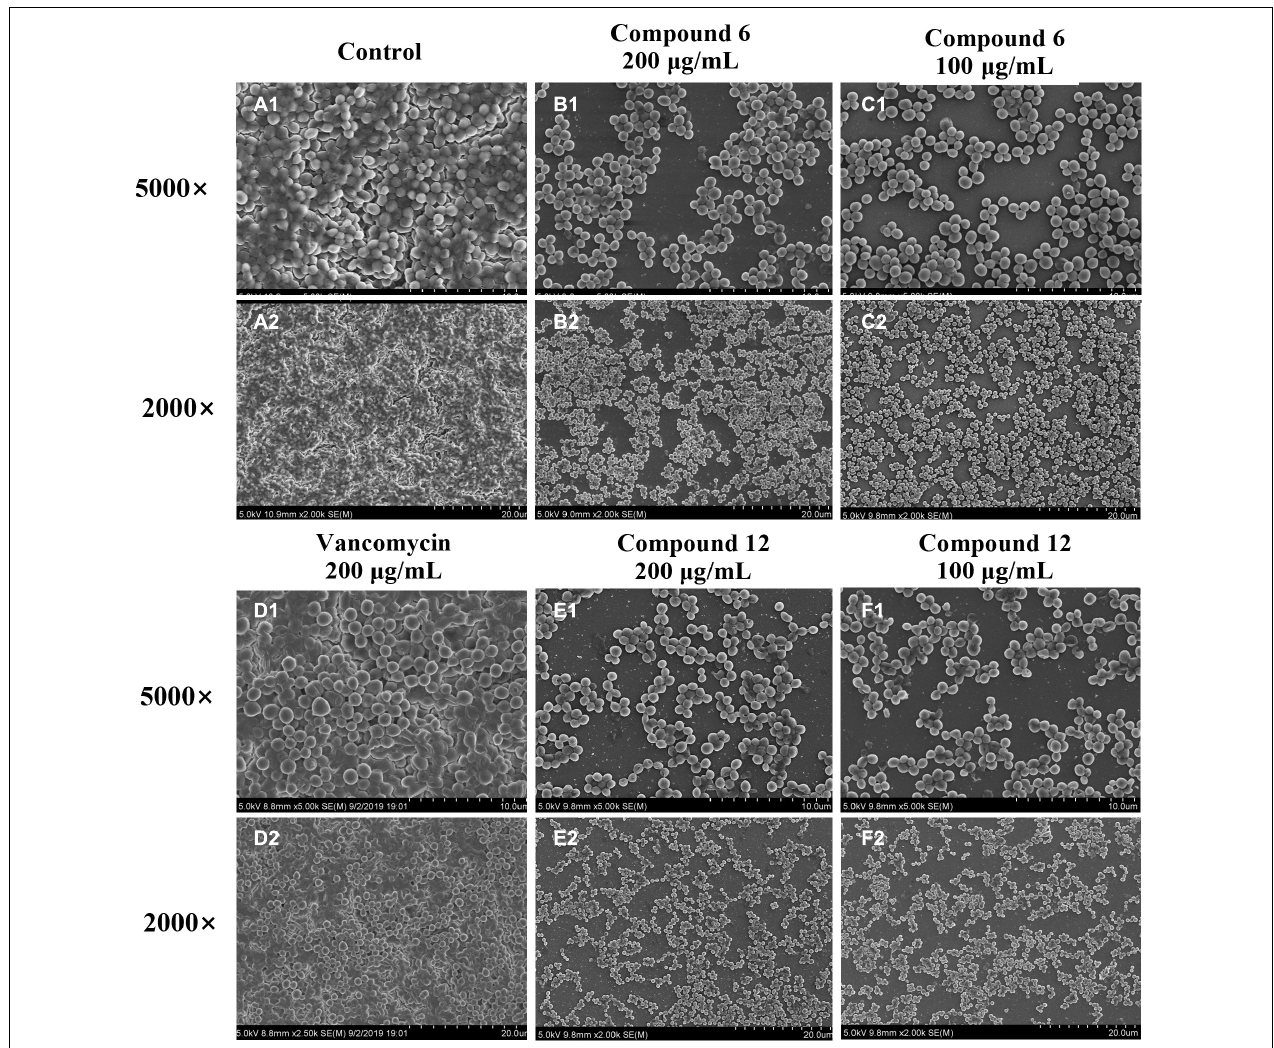
FIGURE 6 | Scanning electron micrographs of 24-h preformed MRSA biofilms treated with different concentrations of compounds 6 and 12 . (A1–F2) Different treatment groups ( A1,A2 DMSO control; B1,B2 200 µ g/ml of compound 6 ; C1,C2 100 µ g/ml of compound 6 ; D1,D2 200 µ g/ml of vancomycin; E1,E2 200 µ g/ml of compound 12 ; F1,F2 100 µ g/ml of compound 12 ). Series 1 and 2 were different magnifications with × 5,000 and × 2,000,